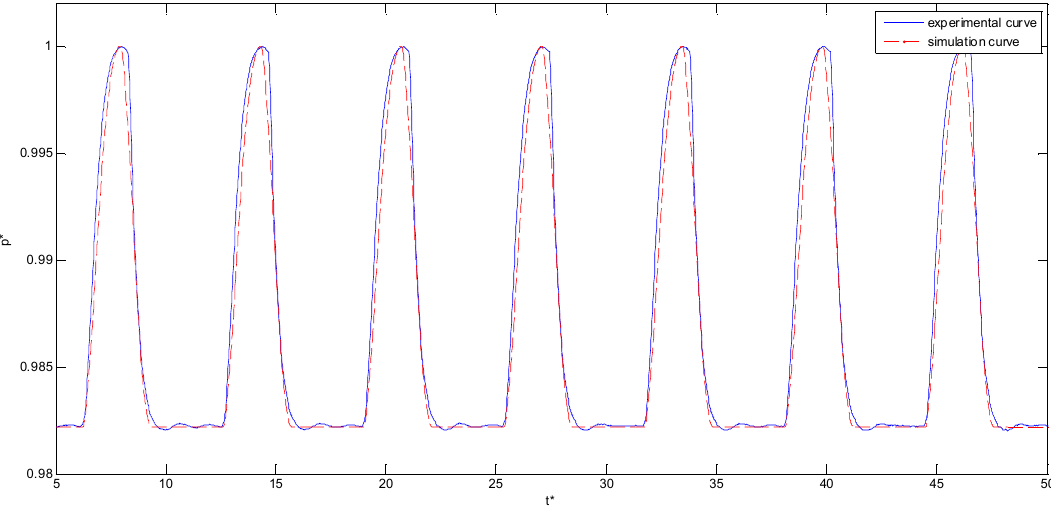
Figure 4. Curve of dimensionless pressure of one lung.